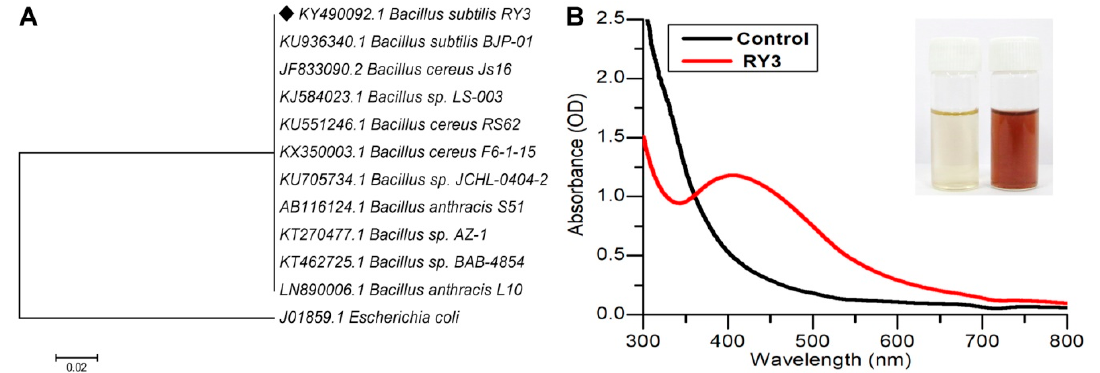
Figure 1. ( A ) Phylogenetic tree of the 16S rDNA sequence of isolate Bacillus subtilis . The bar represents 0.02 substitution per nucleotide position. ( B ) UV-Visible absorption spectrum of biogenic silver nanoparticles (AgNPs) using B. subtilis RY3 supernatant.